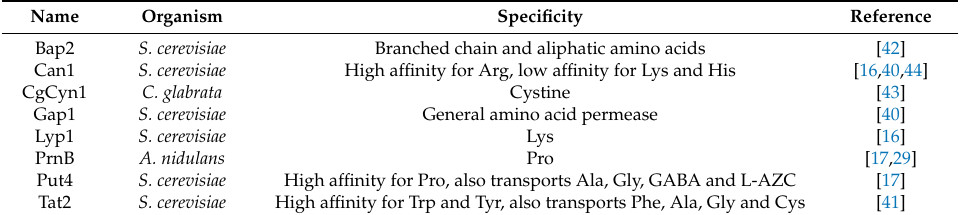
Table 1. Yeast amino acid transporters (YATs) that have been studied by structural